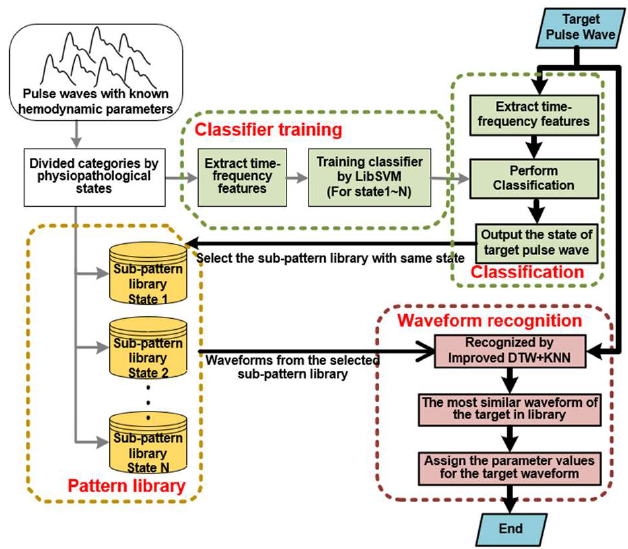
Figure 1. Flowchart methodology.